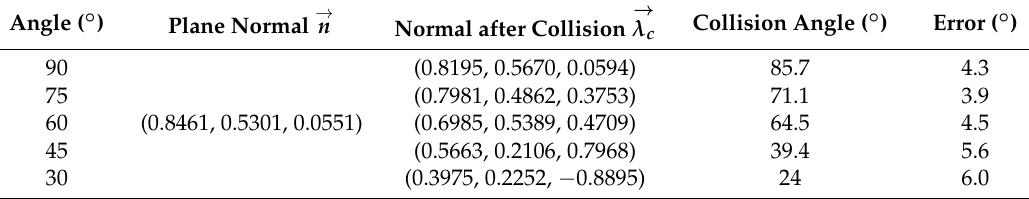
Table 3. Model verification results of